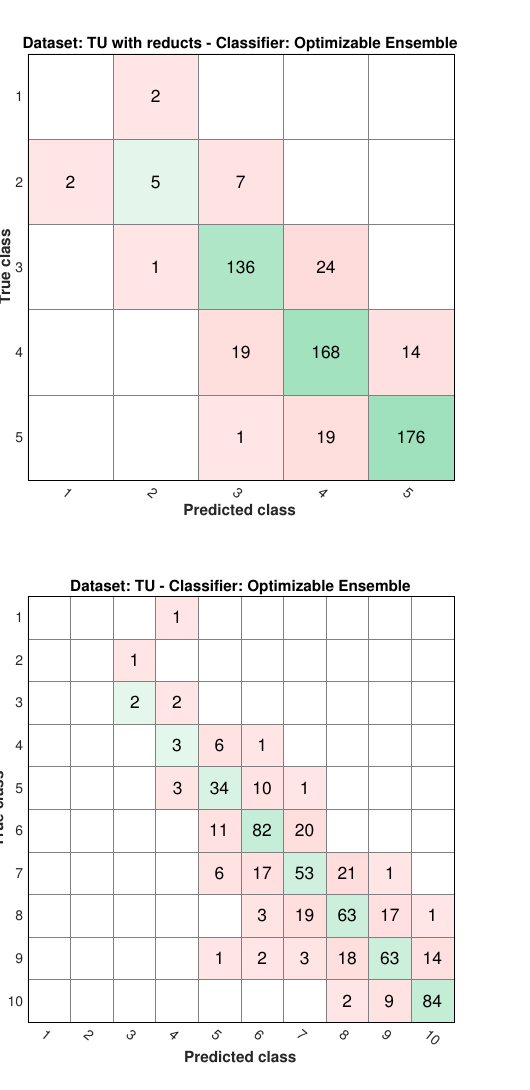
Figure 18. Distributions of TU predicted classes.